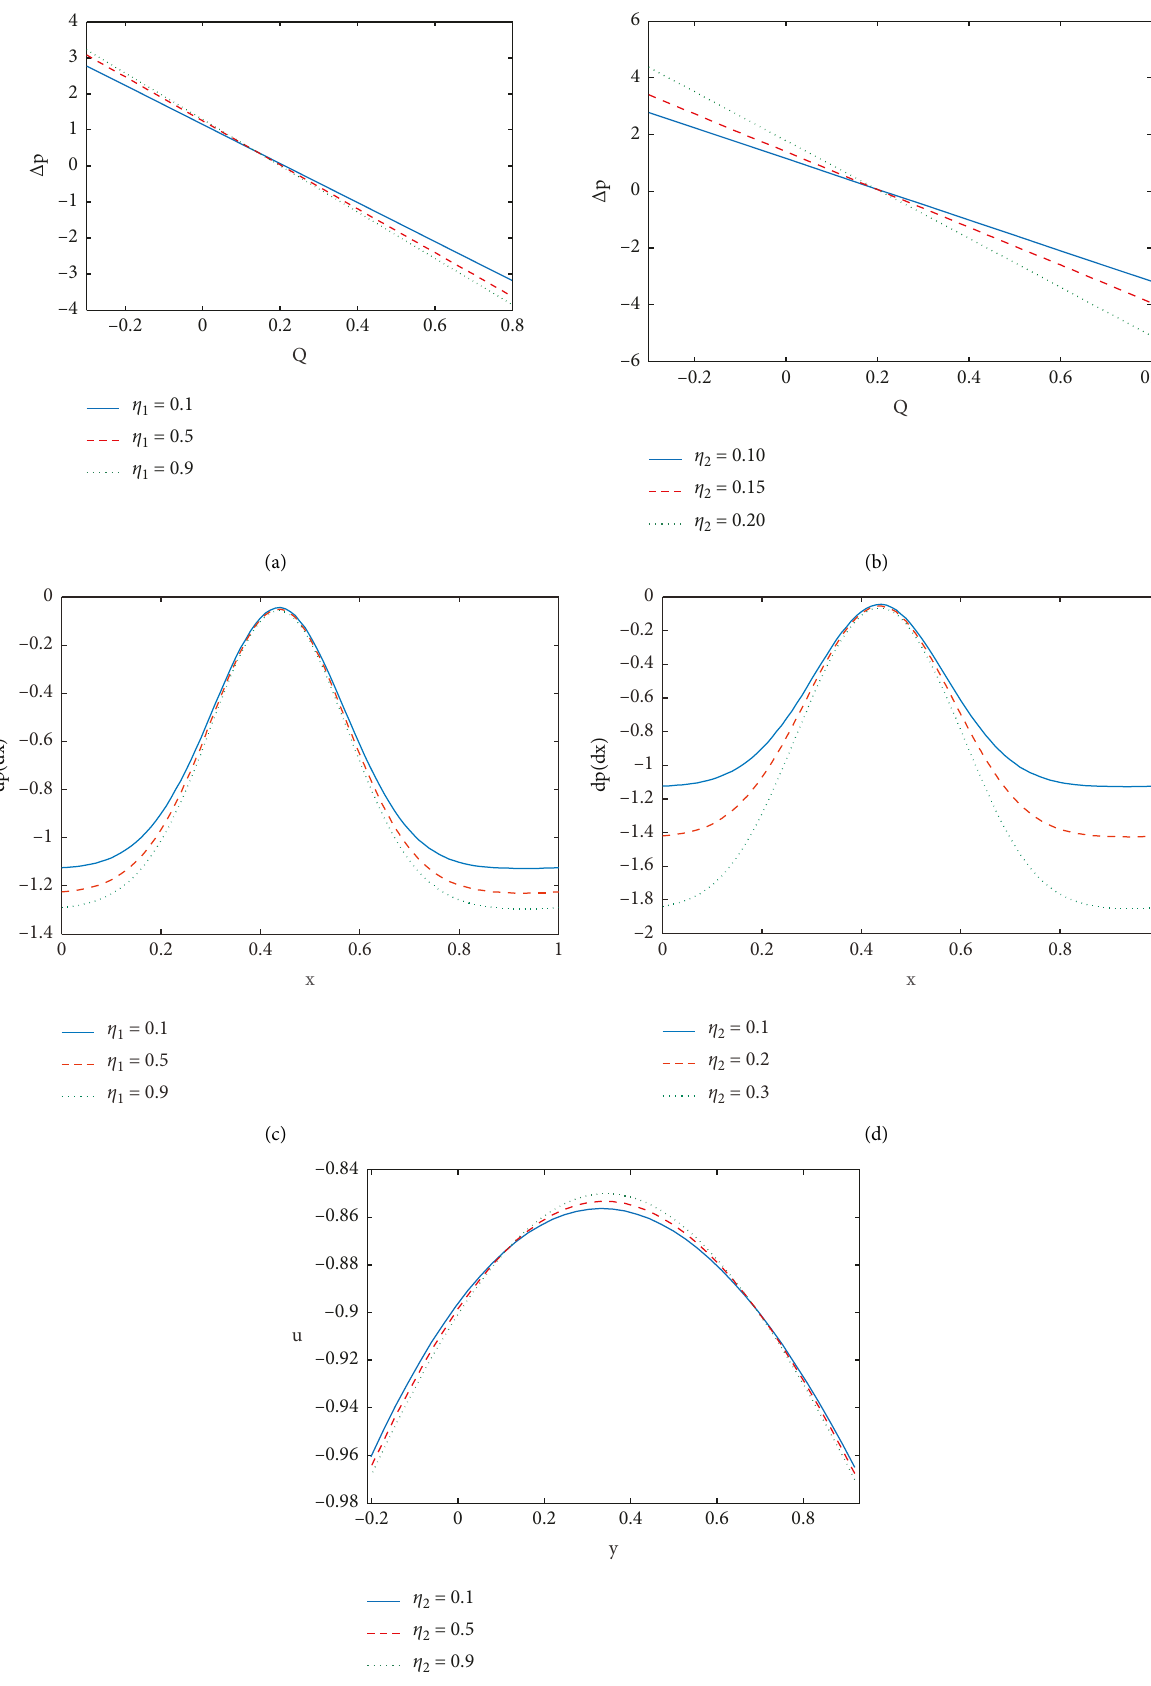
, η ) on Δ p,dp / dx , and u 1 2